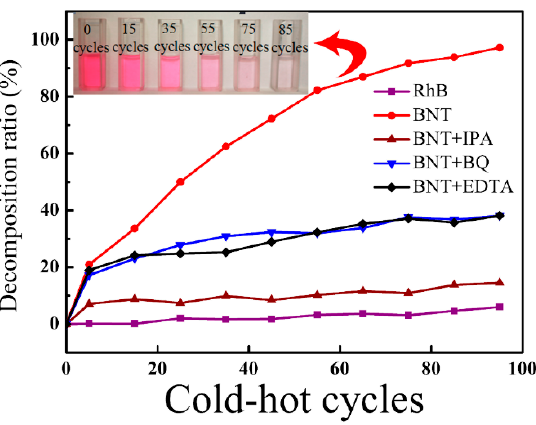
Figure 7. The pyro-catalytic decomposition ratio of RhB and inhibitory effect of different inhibitors on BNT. The inset shows these pictures of RhB dye decomposition.